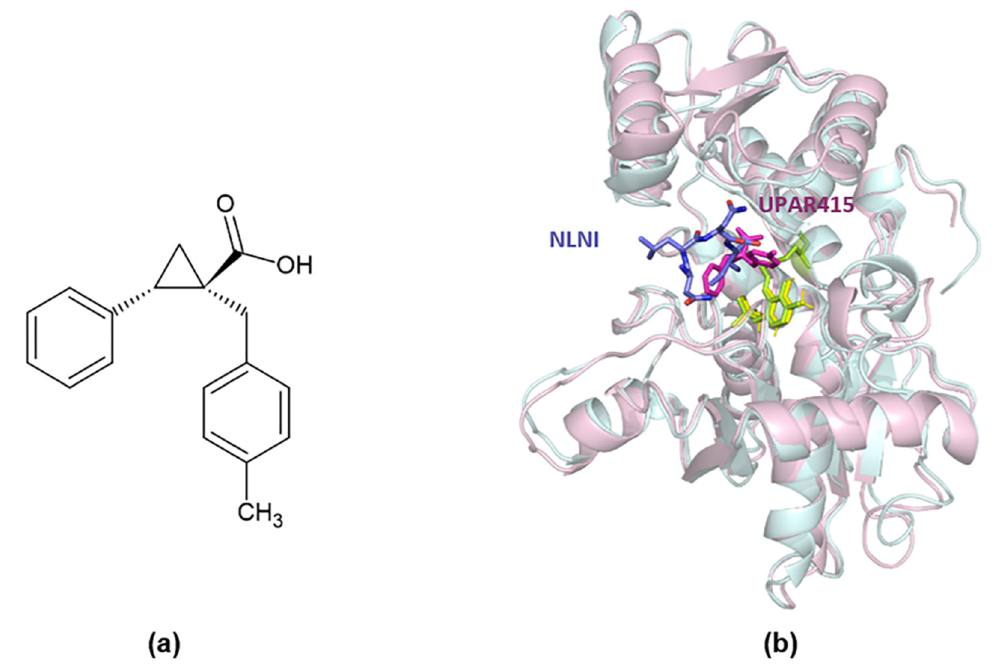
Figure 1. ( a ) UPAR415 ((1S,2S)-1-(4-methylbenzyl)-2-phenylcyclopropanecarboxylic acid) [41]. ( b ) superimposition of an StOASS-A monomer (light cyan) in complex with UPAR415 (magenta, PDB id 6z4n, [49]) and an OASS-A monomer from H. influenzae (light pink) in complex with the NLNI tetrapeptide (violet, PDB id 1y7l, [16]), representing the C-terminal sequence of SAT. UPAR415 is inspired to the C-terminal isoleucine residue, which is key for SAT binding to OASS-A and is conserved in the SAT sequences of S. Typhimurium, E. coli , and H. influenzae . The pyridoxal-5 ′ -phosphate cofactor molecules are represented in yellow (StOASS-A) and green (HiOASS-A).